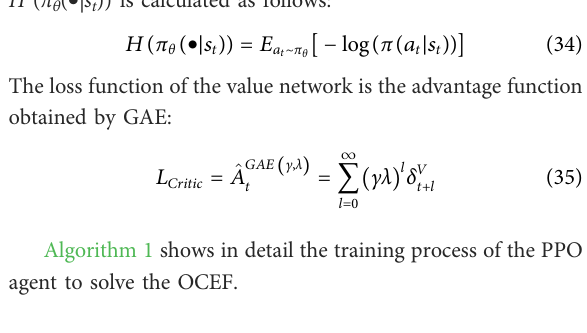
Algorithm 1. PPO training for solving the OCEF problem.